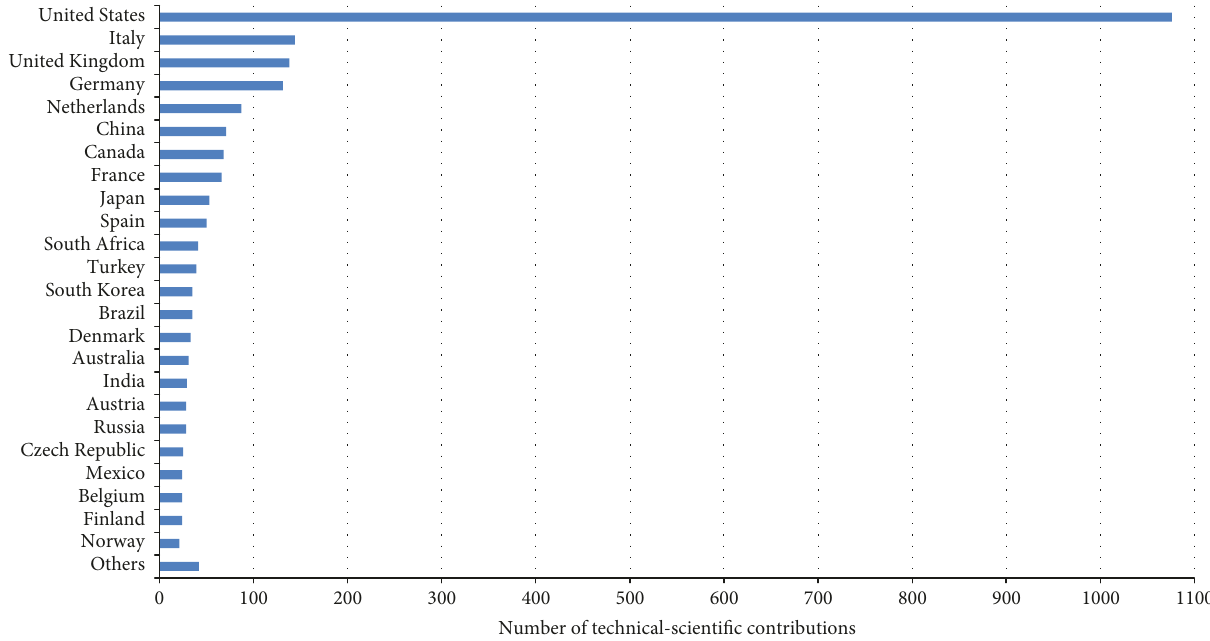
Figure 12: Number of technical-scienti fi c contributions per country between 2005 and